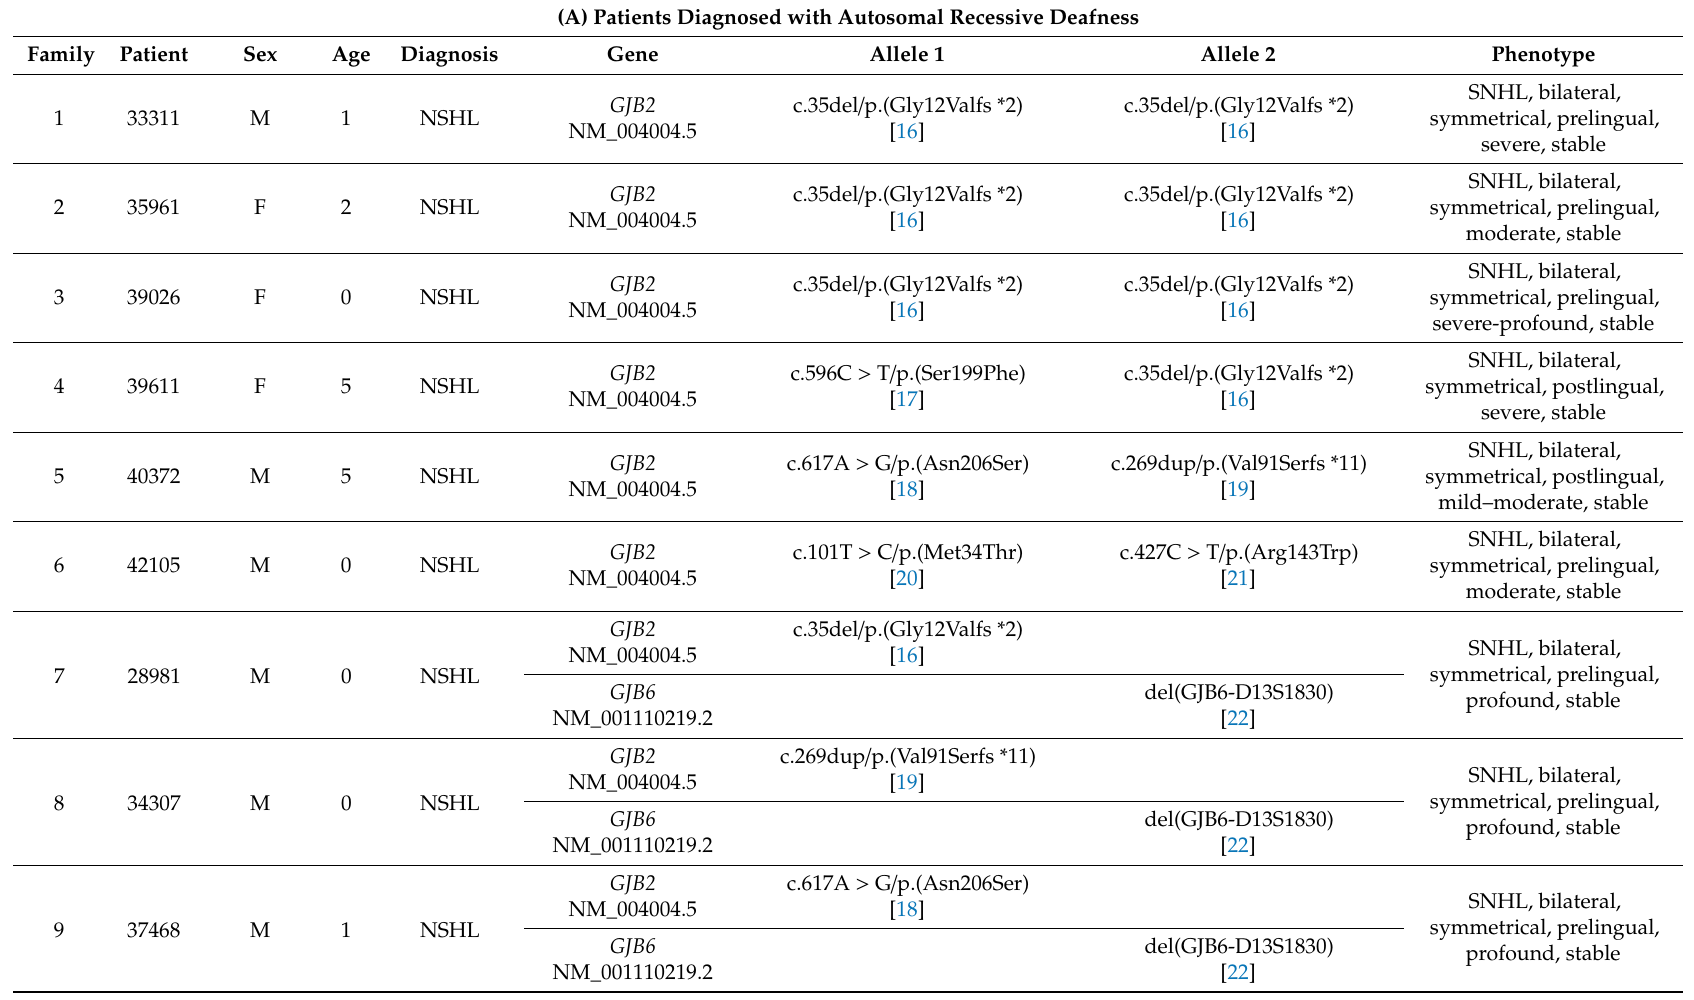
Table 2. Disease Causing Variants Detected and Clinical Data of the Diagnosed